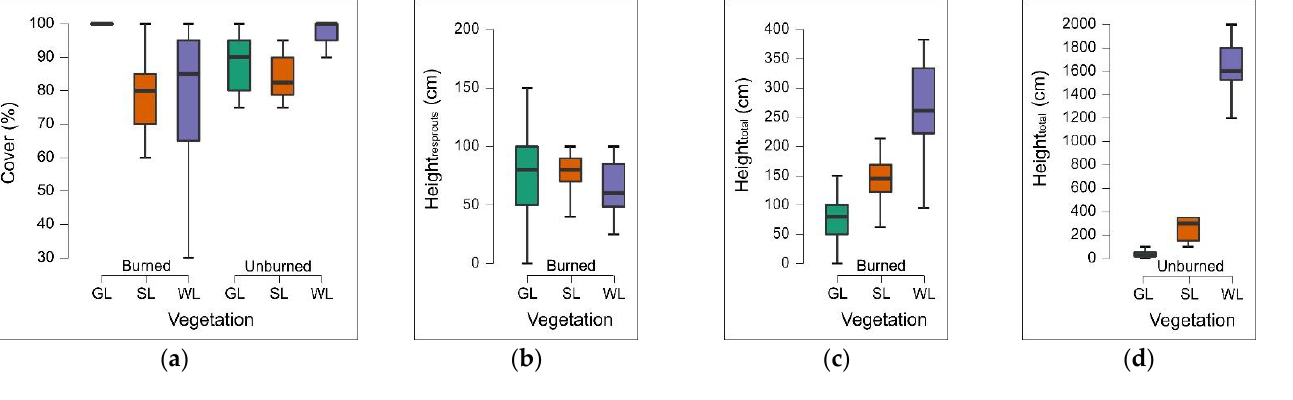
Figure 8. Boxplots of percent coverage, Height resprouts , and Height total . ( a ) Boxplot of percent coverage in burned and unburned grasslands (GL), shrublands (SL), and woodlands (WL). ( b ) Boxplot of Height resprouts and ( c ) Height total in burned vegetation. ( d ) Boxplot of Height total in unburned vegetation. The boxes show the interquartile range, horizontal bars show median values, and vertical bars show the top and bottom 25% quartiles. Table 6. Dunn ’ s post hoc comparison for vegetation cover, Height resprouts , and Height total in the burned area.